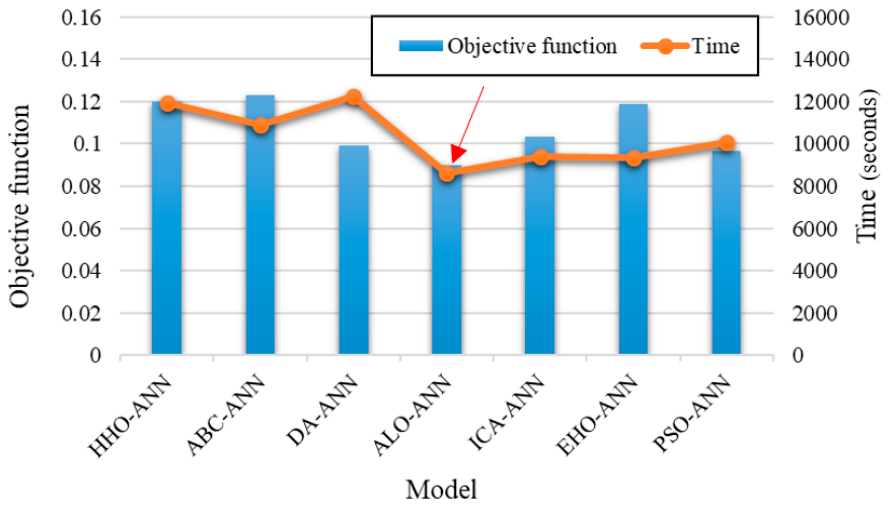
Figure 10. The comparison between the proposed ALO–ANN model and some optimization techniques in terms of computation time and objective function.